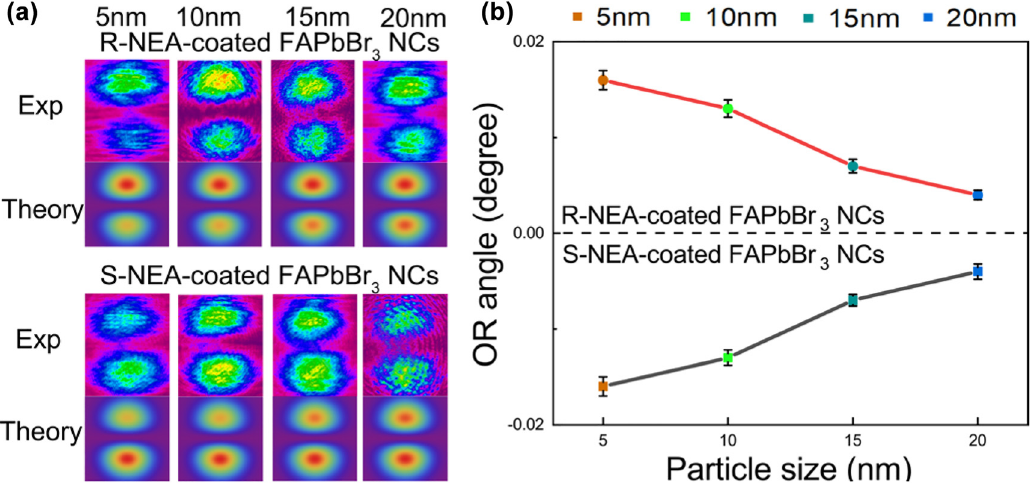
Figure 4: The chirality results of NEA-coated FAPbBr3 NCs with different particle sizes in photonic SHE.(a) The variation of the light spot splitting in theory and experiment, and (b) the OR angle with NEA-coated FAPbBr